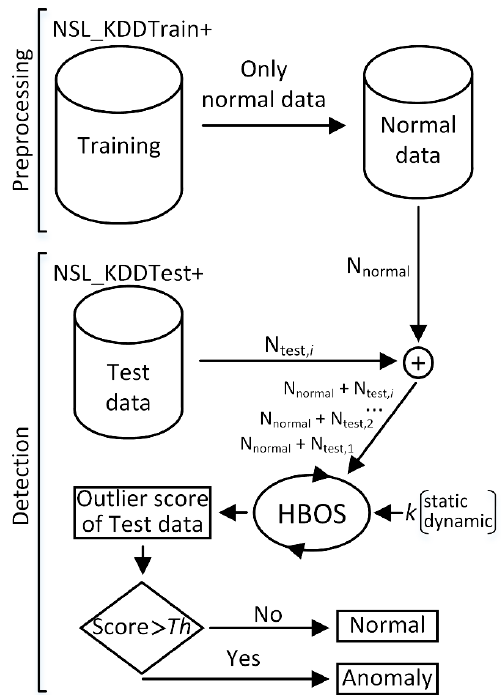
Figure 1. Data preprocessing and anomaly detection scheme. HBOS, histogram-based outlier score; NSL_KDD.